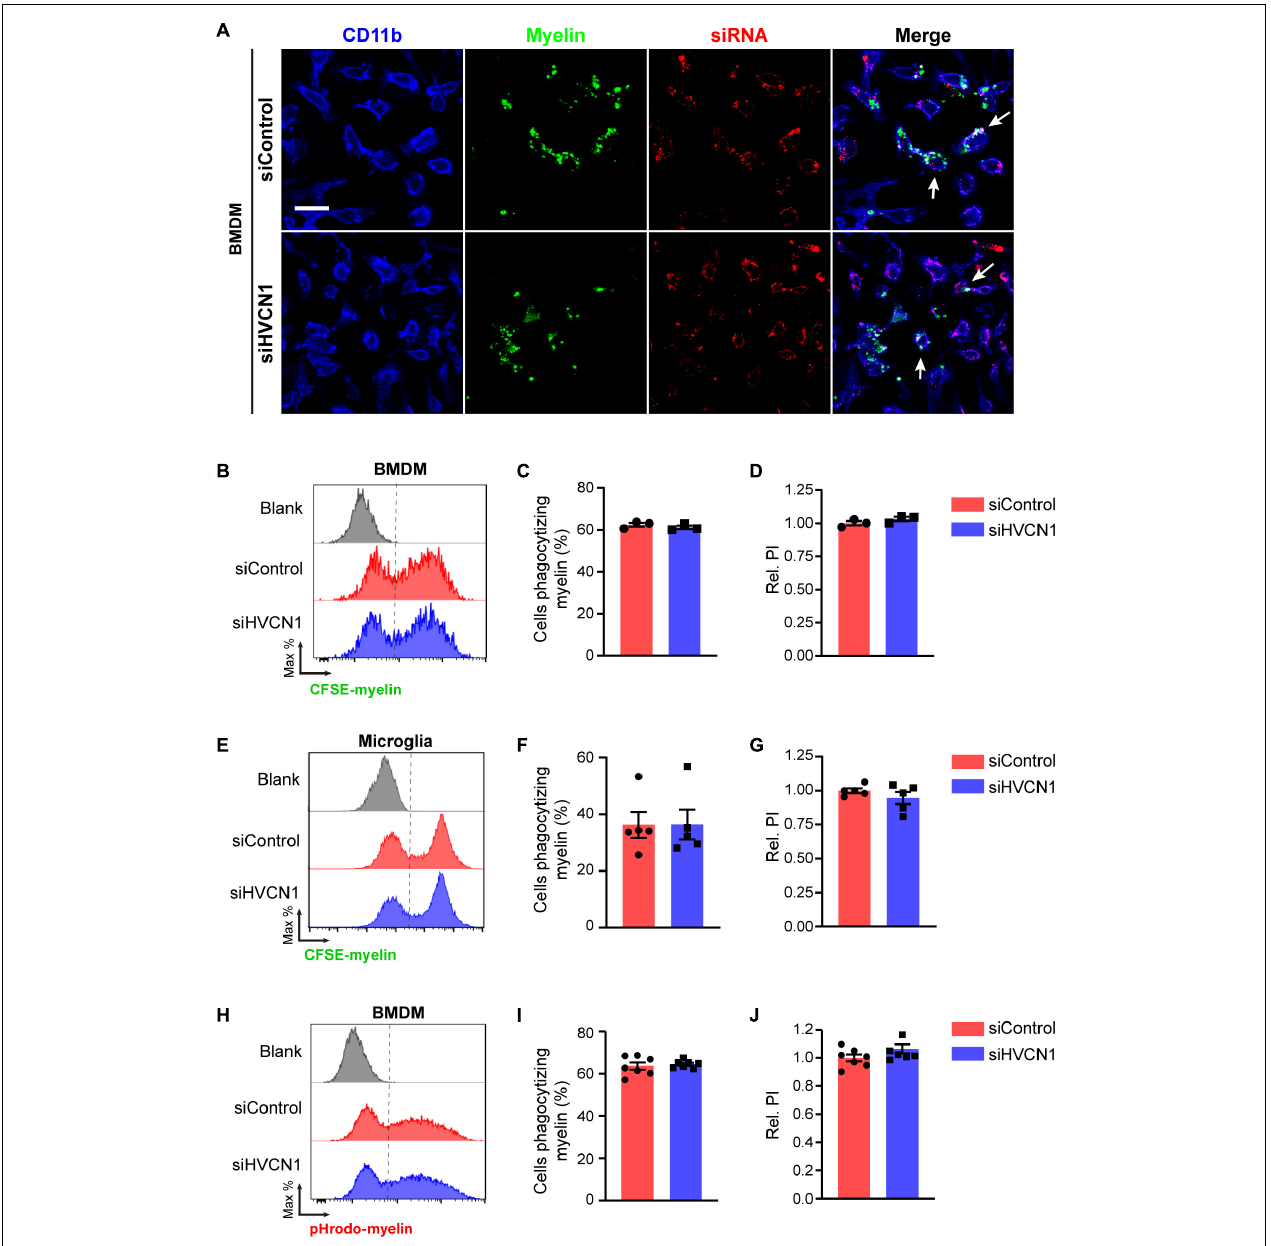
FIGURE 8 | Knockdown of HVCN1 does not affect myelin phagocytosis and lysosome acidification in vitro . (A) Representative immunofluorescence images show that Hvcn1 knockdown by Cy3 labeled siRNA (red) does not affect myelin phagocytosis (green) in CD11b + BMDM (blue). Scale bar = 100 µ m. Arrows indicate two example BMDM cells that phagocytized myelin. Flow cytometry chart (B) and the quantification graphs (C,D) show that Hvcn1 knockdown does not affect both the proportion of cells phagocytizing myelin (C) and the relative phagocytic index (D) in CFSE-labeled myelin phagocytosis assay in BMDM cells ( n = 3). Flow cytometry chart (E) and the quantification graphs (F,G) show that Hvcn1 knockout does not affect both the proportion of cells phagocytizing myelin (F) and the relative phagocytic index (G) in CFSE-labeled myelin phagocytosis assay in primary cultured microglia cells ( n = 5). Flow cytometry chart (H) and the quantification graphs (I,J) show that Hvcn1 knockdown does not affect the proportion of cells phagocytizing myelin (I) and the relative phagocytic index (J) in pHrodo-myelin phagocytosis assay in BMDM cells ( n = 7). Data are presented as mean ± SEM. Statistical tests: unpaired two-tailed t -test (C,D,F,G,I,J) .